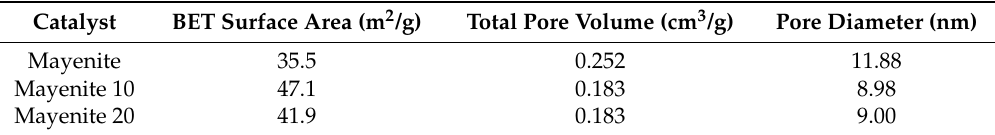
Table 1. BET surface area of the different synthesized catalysts.